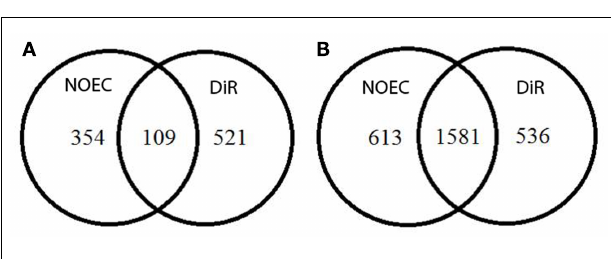
FIGURE 3 |Venn diagrams showing the number of genes responding to NOEC and DiR levels of toxicants in the Soil exposure (A) and in Extract exposure